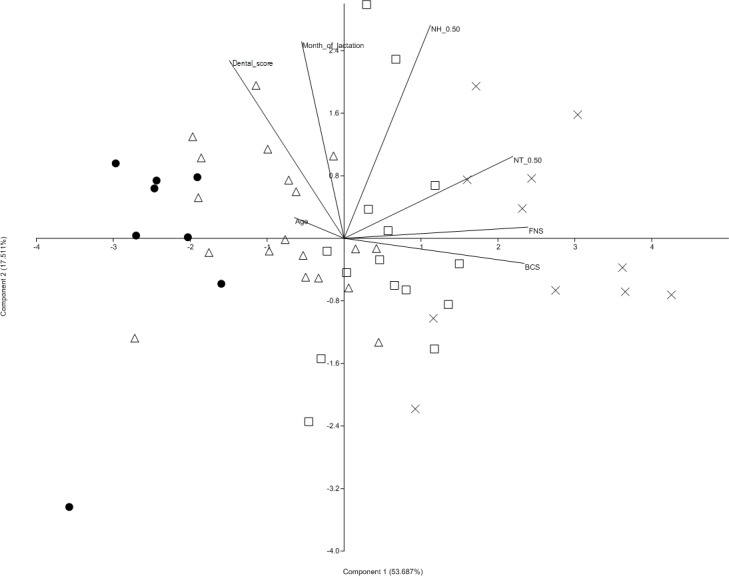
 Principal component analysis performed on selected animal-based indicators of the body condition. In order to improve the visualization of the PCA results, different symbols were assigned arbitrarily.● body condition score (BCS) < 2; △ BCS < 3; □ BCS < 4; x BCS > 4. NT, neck thickness; FNS, fatty neck score; NH, neck height.